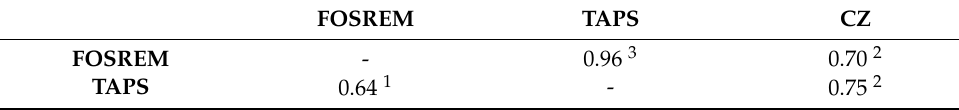
Table 1. Pearson correlation coefficients between all the sensors.